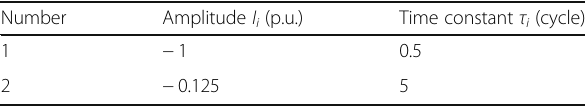
Table 3 Parameters of decaying DC offset